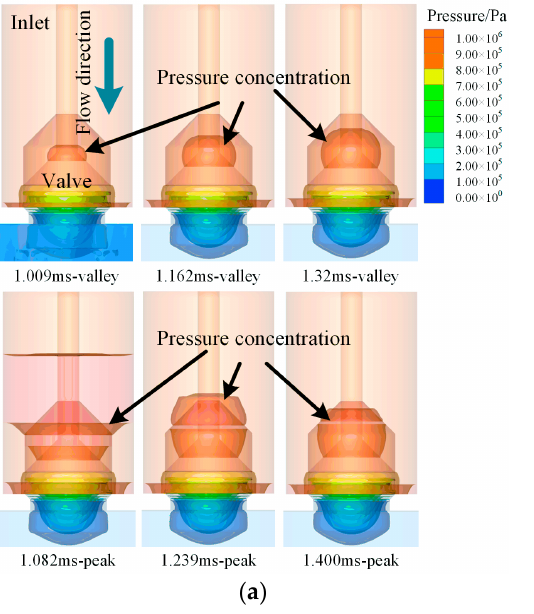
Figure 12. ( a ) Throat near-field pressure distribution of the case with no vibration (left). ( b ) Throat near-field pressure distribution of cases with vibration (case 2, for example; right).